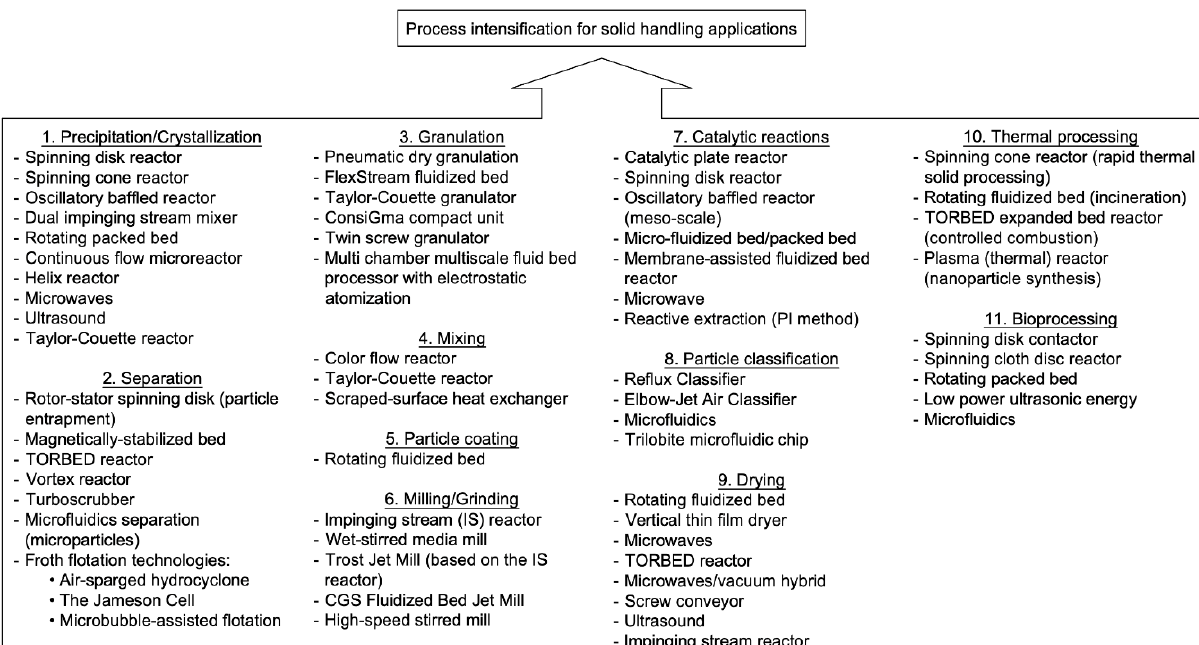
Figure 1. Modern intensive technologies and methods for processes associated with solids processing devices [13].